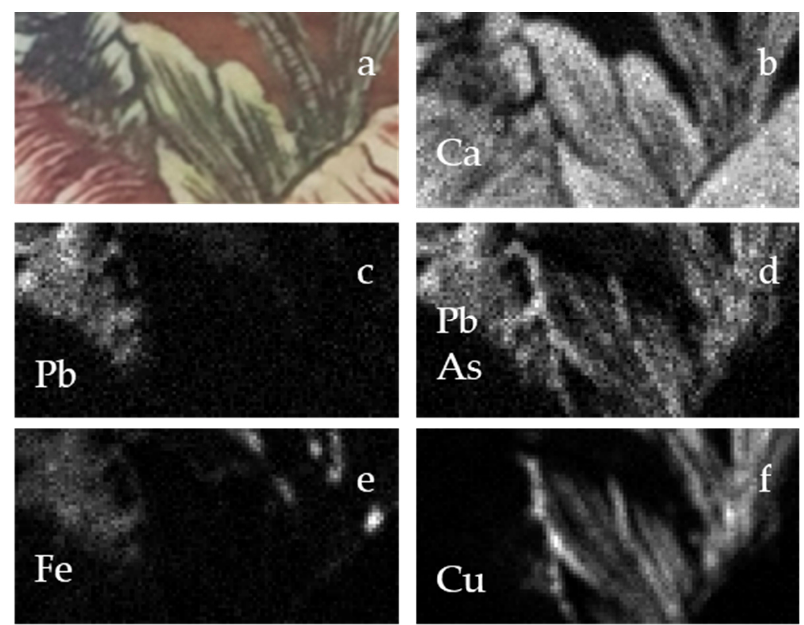
Figure 6. Elemental maps of the second area of the drawer. ( a ) Visible. The maps presented are: ( b ) Ca K α transition; ( c ) Pb L β transition; ( d ) Pb L α /As K α transitions; ( e ) Fe K α transition; ( f ) Cu K α transition.